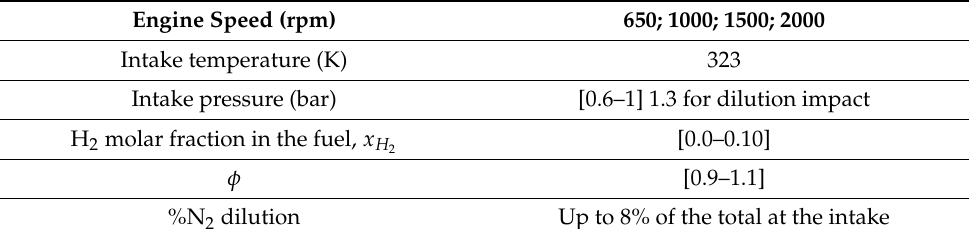
Table 3. Overview of the test conditions.